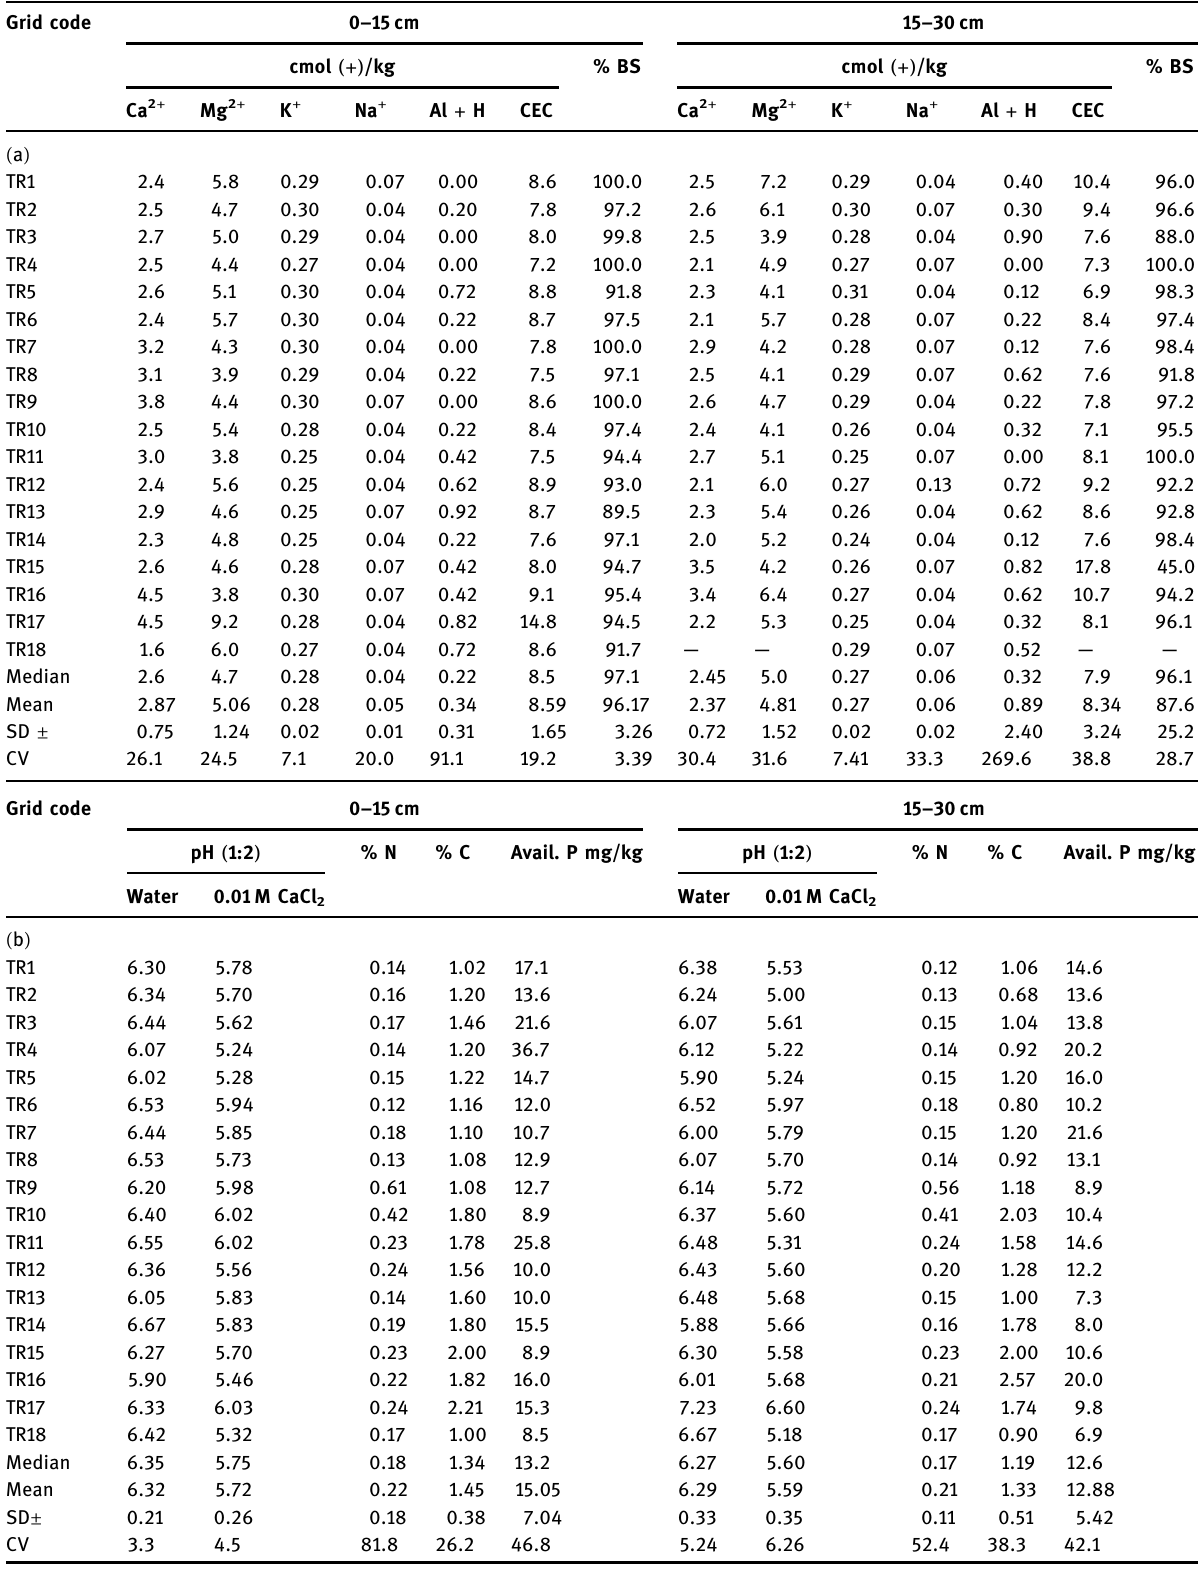
Table 2: ( a ) Chemical properties of the soils. ( b ) Chemical properties of the soils Grid